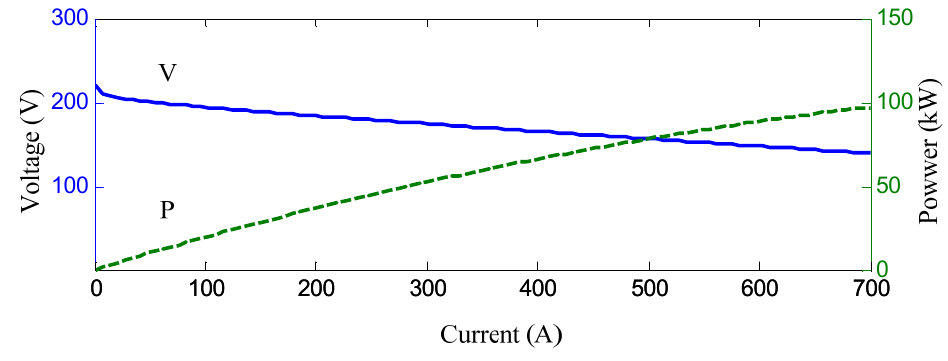
Figure 3. Typical characteristics of voltage, power vs.